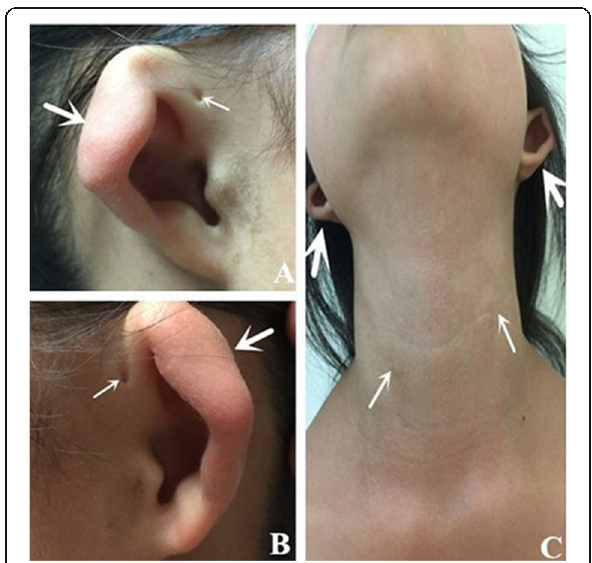
Fig. 2 Images of both ears with microtia, preauricular pits, and branchial cleft fistulae in subject III:5. a and b Small arrows indicate preauricular pits, and large arrows indicate microtia. c Small arrows indicate branchial cleft fistulae, and large arrows indicate microtia